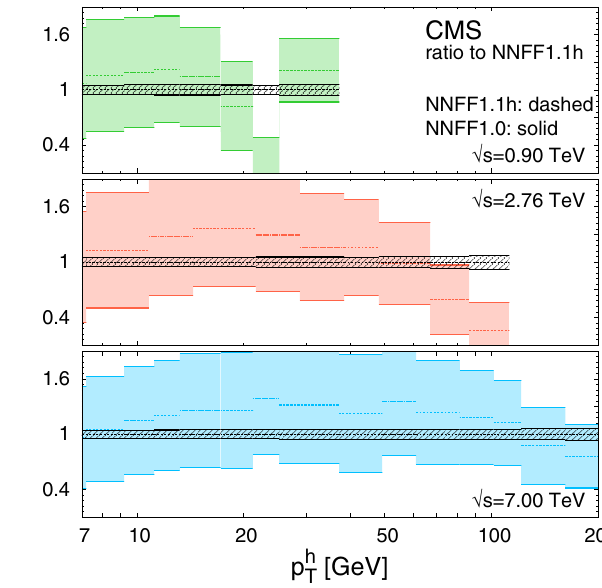
Fig. 7 Comparison of the gluon (upper) and singlet (lower plot) FFs Fig. 8 Theoretical predictions for the differential cross sections in pp = 7 GeV and at Q = 10 GeV for the NNFF1.1h fits with p h collisions, Eq. (2), computed at NLO in the kinematic bins measured T , cut = 10 GeV, normalised to the former by CMS. We compare the predictions obtained from the unidentified p h T , cut charged hadron in the NNFF1.1h set with those obtained from the sum of charged pions, kaons and protons/antiprotons in the NNFF1.0 set. Predictions are normalised to